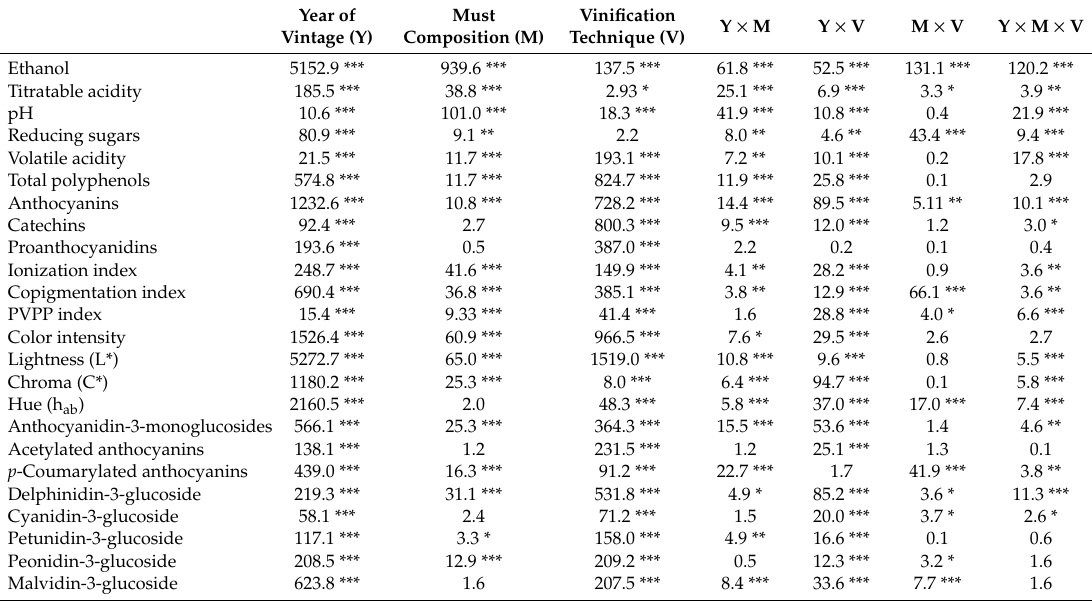
Table 5. Multifactorial analysis of